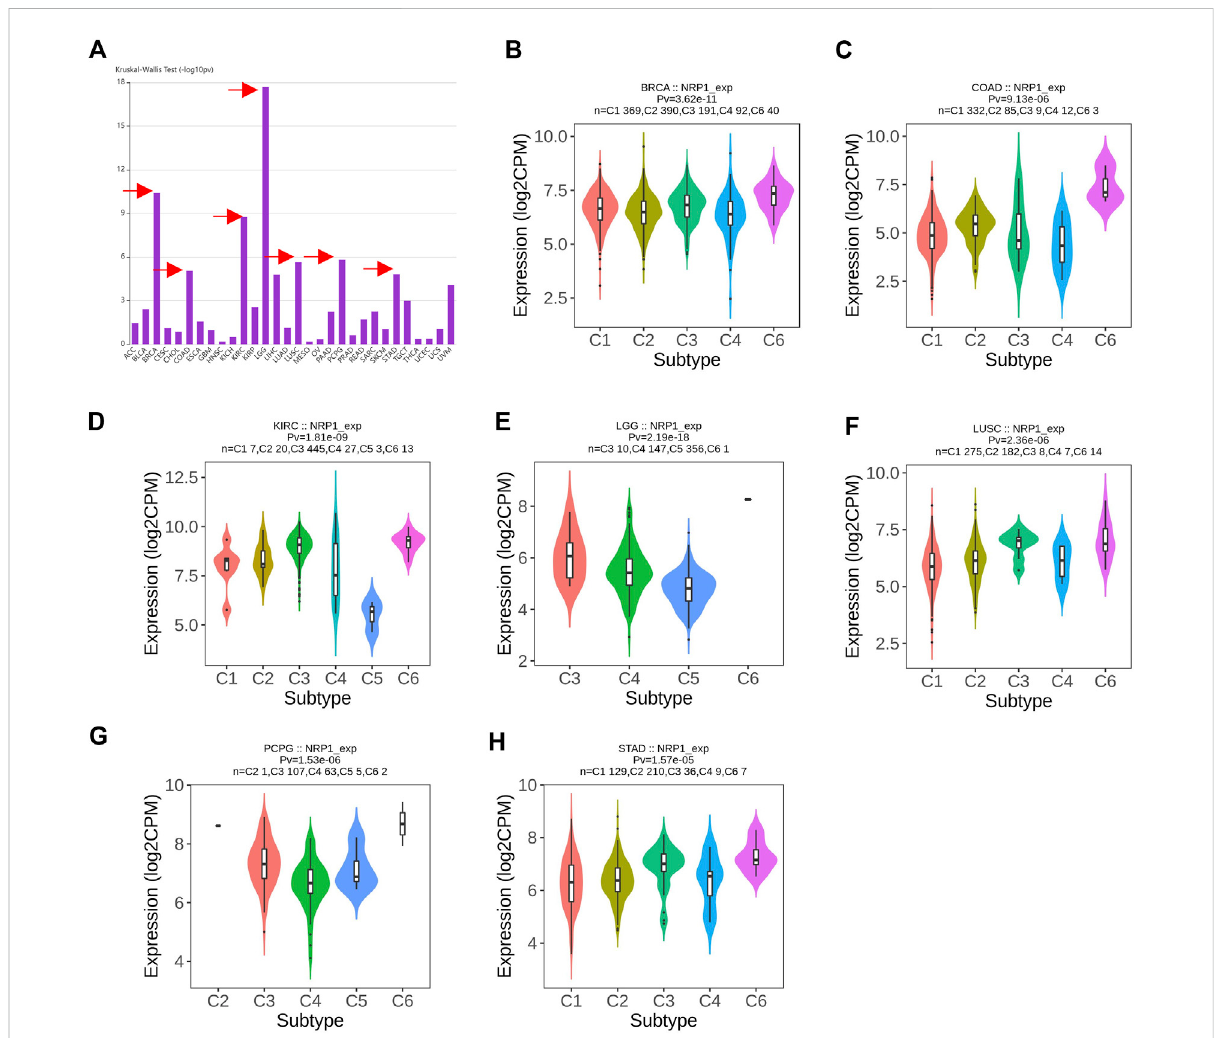
A pan-cancer landscape of NRP1 expression in different immune subtypes (A) Differential analysis of NRP1 expression among the six immune subtypes in different cancer types. Arrows indicated the top seven cancer types differentially expressing NRP1 among the six immune subtypes. (B – H) Violin plots showing NRP1 expression in the six immune subtypes in LGG, BRCA, KIRC, PCPG, LUSC, COAD, and STAD,